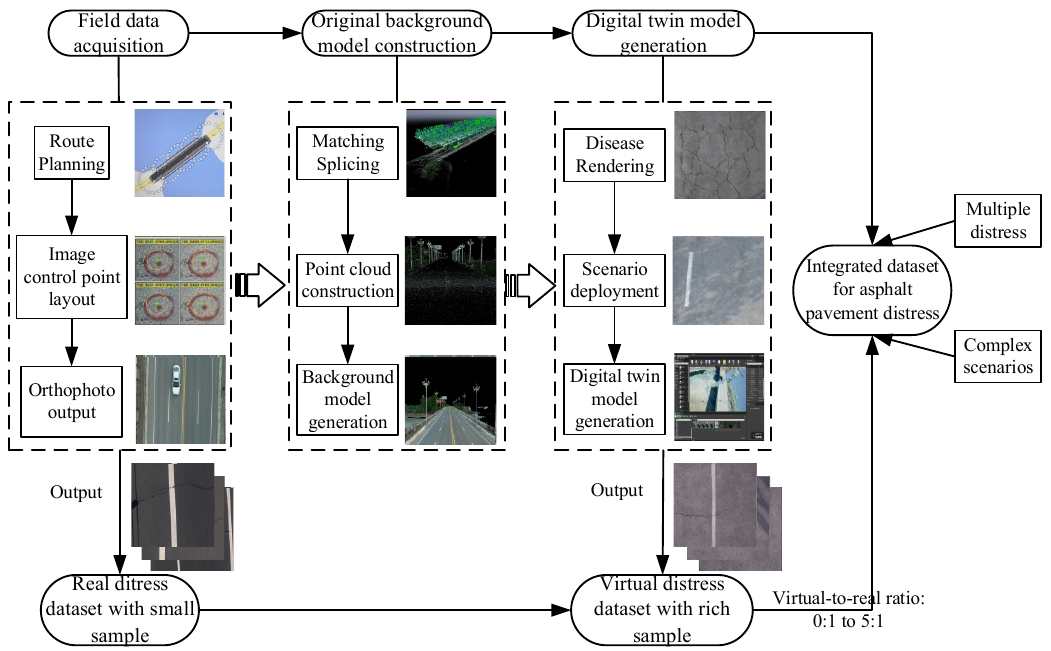
Figure 2. Flow of integrated dataset generation for asphalt pavement distress based on digital twin.